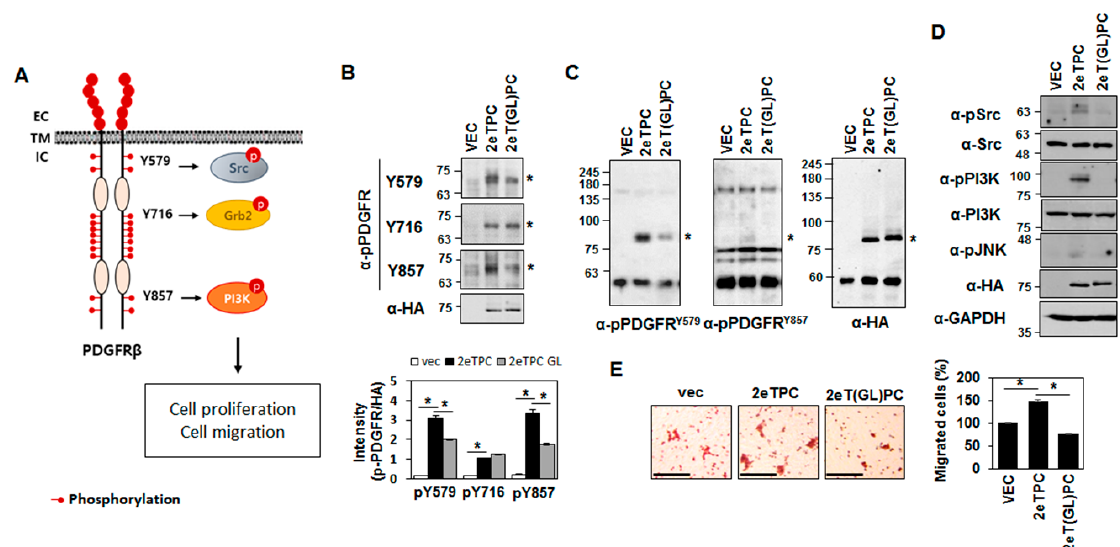
Figure 5. Transmembrane domain-induced dimerization specifically regulates the phosphorylation on Tyr 579 in the cytoplasmic domain of PDGF receptor. ( A ) Schematics of PDGF receptor β signaling. The site-specific tyrosine phosphorylation at the cytoplasmic domain and the relevant interacting signaling molecules are indicated. (B-E) HEK293T cells were transfected with vec, 2eTPC, and 2eT(GL)PC chimeras. ( B ) Tyrosine phosphorylation of each chimeric protein was determined by Western blotting analysis using phosphorylation-specific antibodies against p-PDGFR Y579, Y716, and Y857 (upper panel). The relative densitometric intensity was quantified (bottom panel). Migration positions of SDS-resistant monomers (*) are indicated. ( C ) Total cell lysates were immunoprecipitated with an anti-HA antibody and subjected to Western blotting with antibodies against p-PDGFR Y579, Y716, and Y857. ( D ) Whole-cell lysates were prepared and analyzed by Western blotting with the indicated antibodies. An antibody against GAPDH was used as a loading control. ( E ) HEK293T cells were used for Transwell migration assays, with 10% FBS applied as a chemoattractant in the lower chamber. Cells were allowed to migrate for 18 h and stained with 0.6% hematoxylin and 0.5% eosin (left). Scale bar = 100 µ m. The migrated cells were counted (right). The data shown are representative of three independent experiments. Bars represent average ± standard deviation; * p <